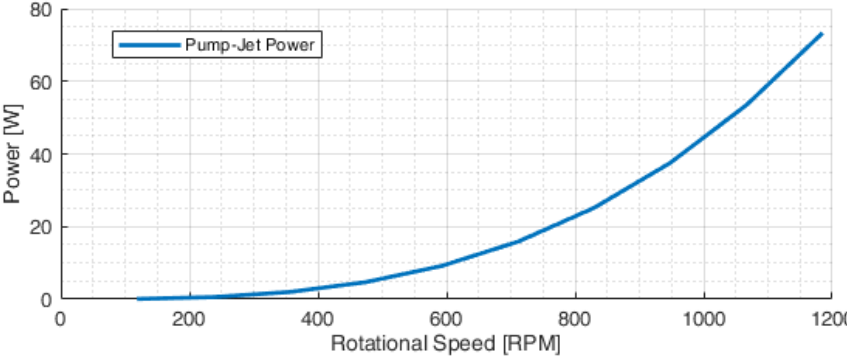
Figure 13. The expected PJM power